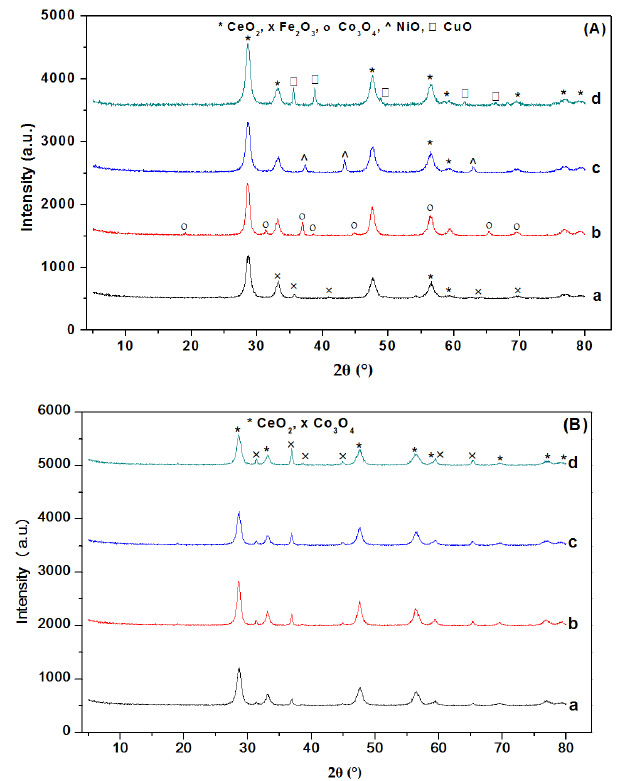
Figure 1. X ‐ ray powder diffraction patterns of 20 wt.% M/CeO 2 catalysts ( A ) where M stands for Fe (a), Co (b), Ni (c) and Cu (d), and of Co/CeO 2 catalysts ( B ) with 15 (a), 20 (b), 25 (c) and 30 wt.% (d) Co loading.